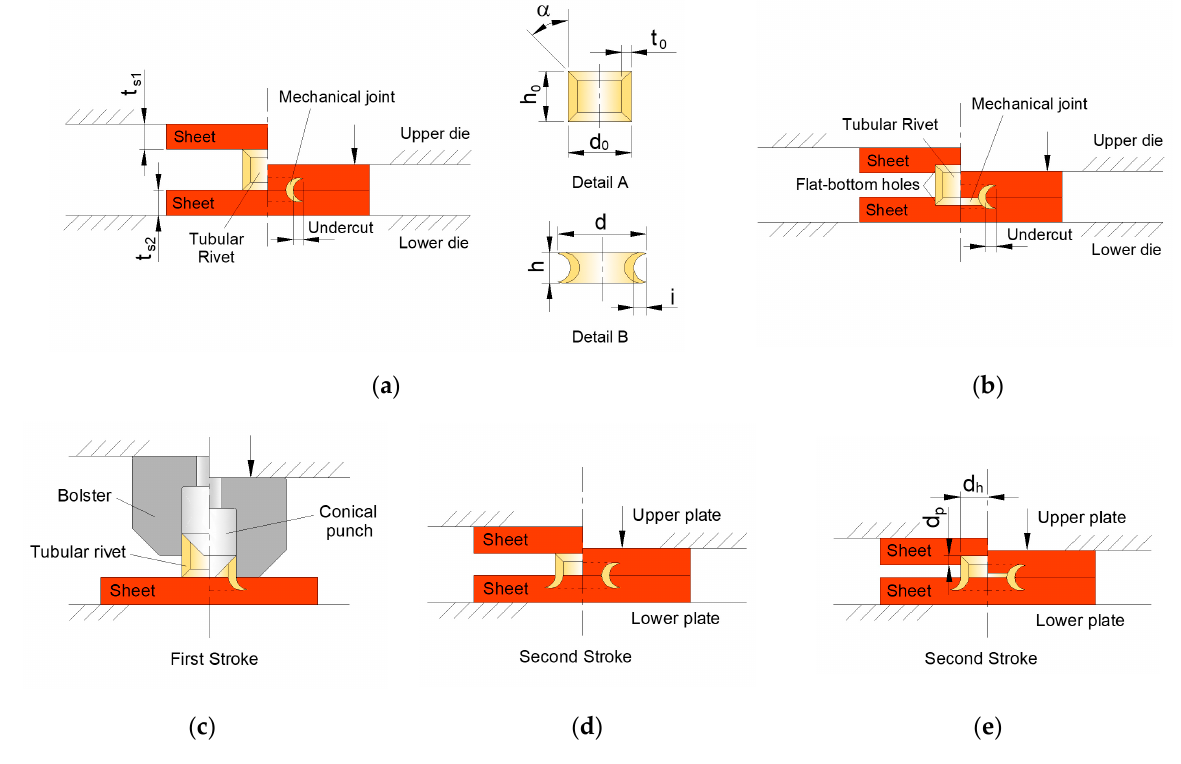
Figure 3. ( a ) Conventional DSSPR with notation of the process parameters and details of the tubular rivet in each stage, ( b ) DSSPR with a flat-bottom hole in each sheet, and ( c ) pre-riveting of one sheet and subsequent assembly to a ( d ) plain sheet or ( e ) a sheet with a flat-bottom hole. Table 1. Operating process parameters utilized in the experimental and numerical evaluation of different possible strategies of DSSPR (refer to Figure